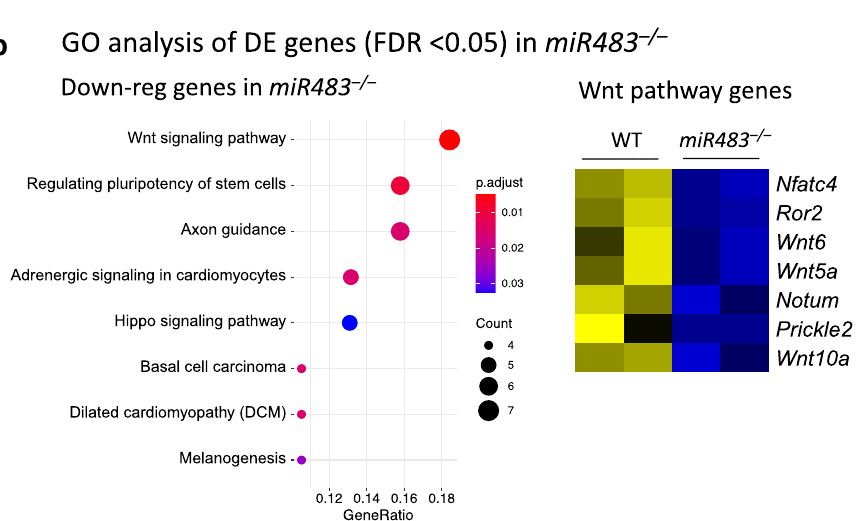
Figure 4. Pathway analysis of RNA-seq data comparing miR483 +/+ and miR483 −/− C2C12 cells on an Igf2 +/+ background. ( a ) Gene set enrichment analysis of ranked DE genes in miR483 −/− cells using hallmark gene sets (top) and heatmap of the genes contributing to the myogenesis or P53 pathway (below). ( b ) KEGG pathway analysis of down-regulated genes in miR483 −/− cells and heatmap of Wnt pathway-related